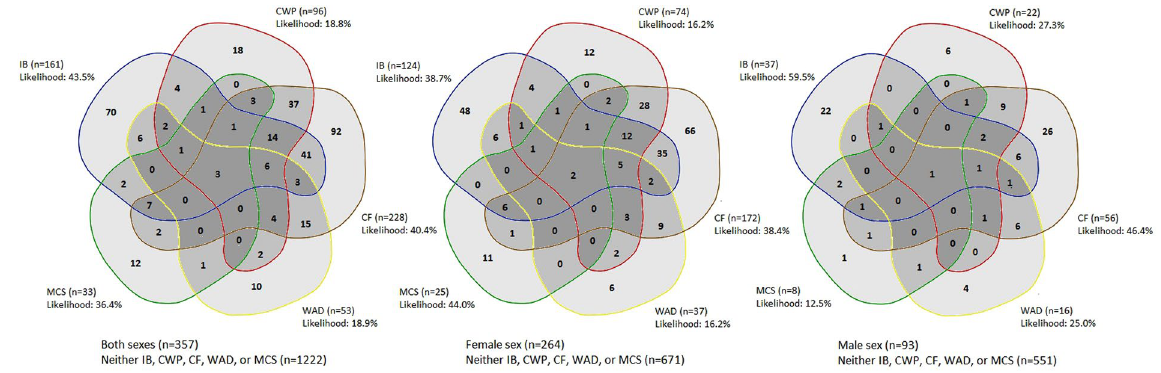
Figure 1. Overlap of functional somatic